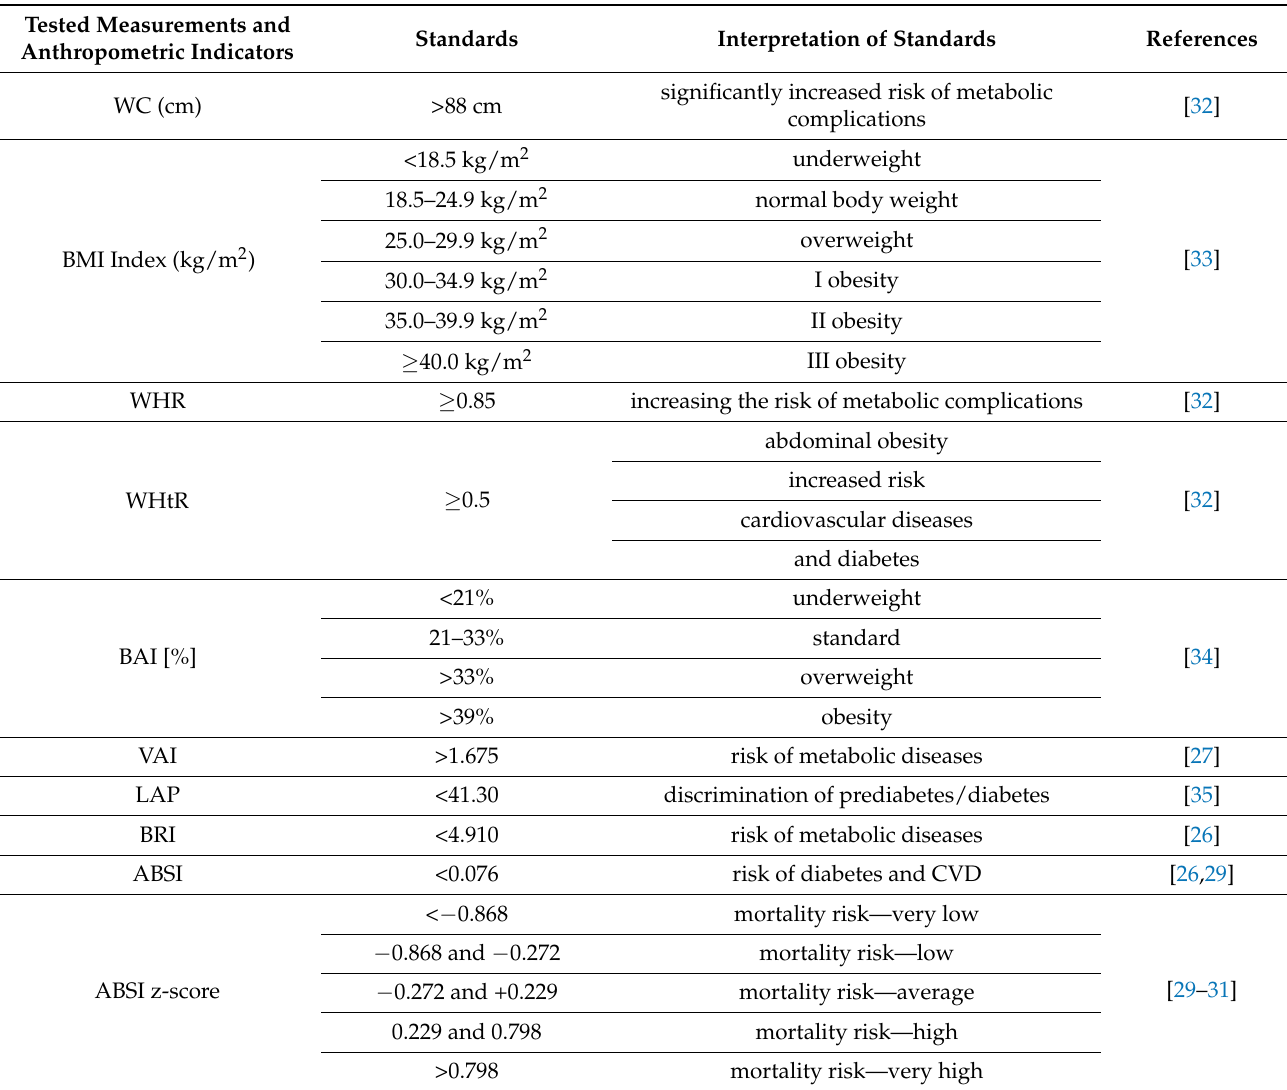
Table 1. Interpretation of anthropometric parameters and indices. Tested Measurements and Anthropometric